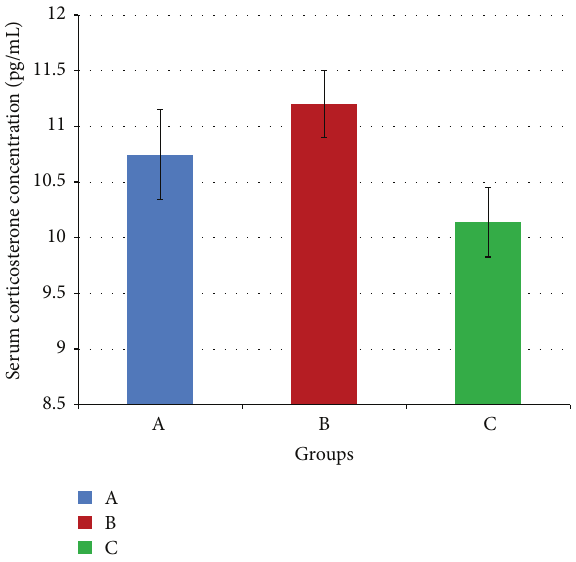
Figure 2: Mean serum corticosterone concentrations of rats in groups A, B, and C at the end of the four-week treatment period. group A: control (HSD/HFD); group B: stress + HSD/HFD; group C: stress + GA + HSD/HFD. Abbreviations: GA: glycyrrhizic acid, HSD: high-sucrose diet, and HFD: high-fat